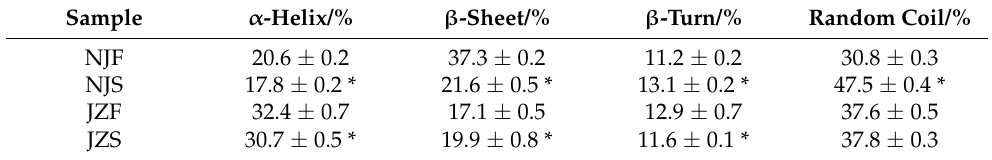
Table 1. Influence of storage on secondary structural contents of rice protein in two varieties (n = 3, α = 0.05).